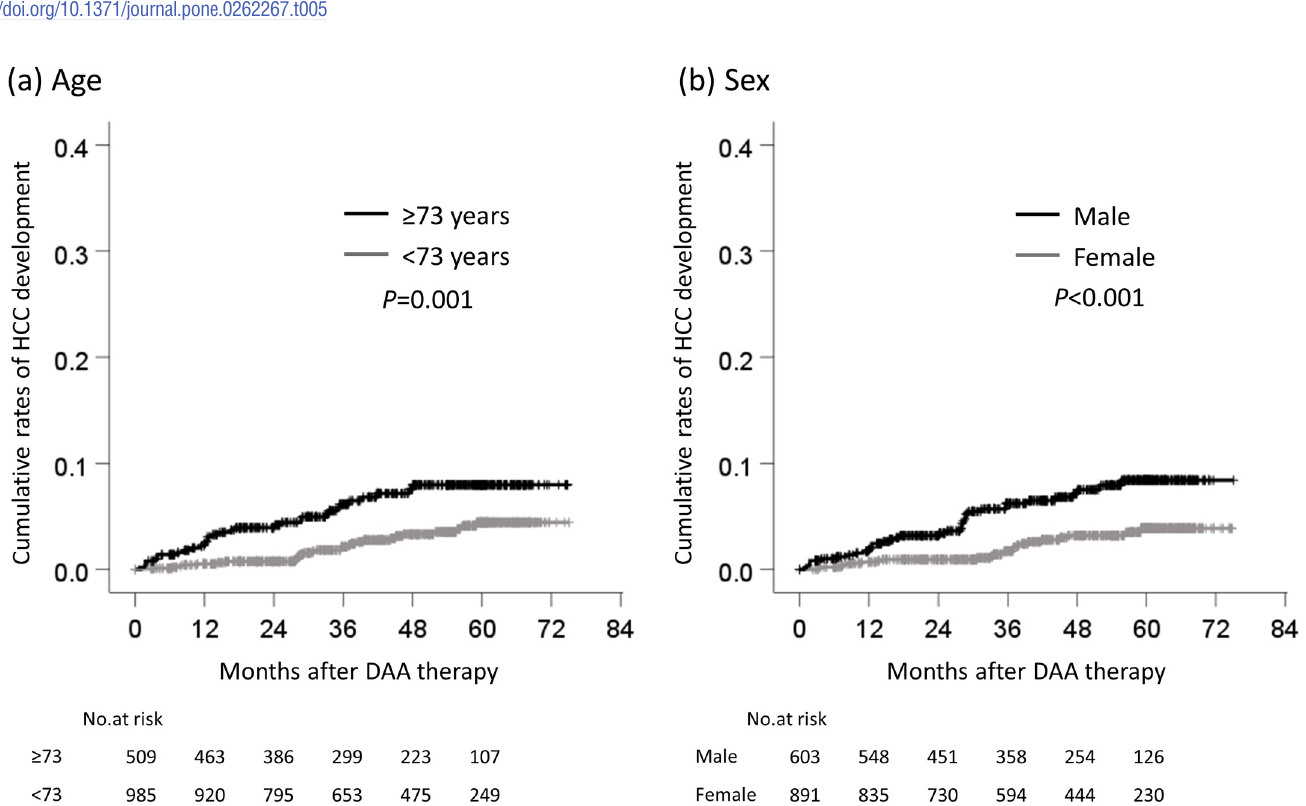
Fig 3. The cumulative rates of HCC development by age and sex. The comparison of the cumulative rates of HCC development (a) between � 73 years of age and < 73 years of age, (b) between male and female. HCC, hepatocellular carcinoma; DAA, direct-acting antiviral.